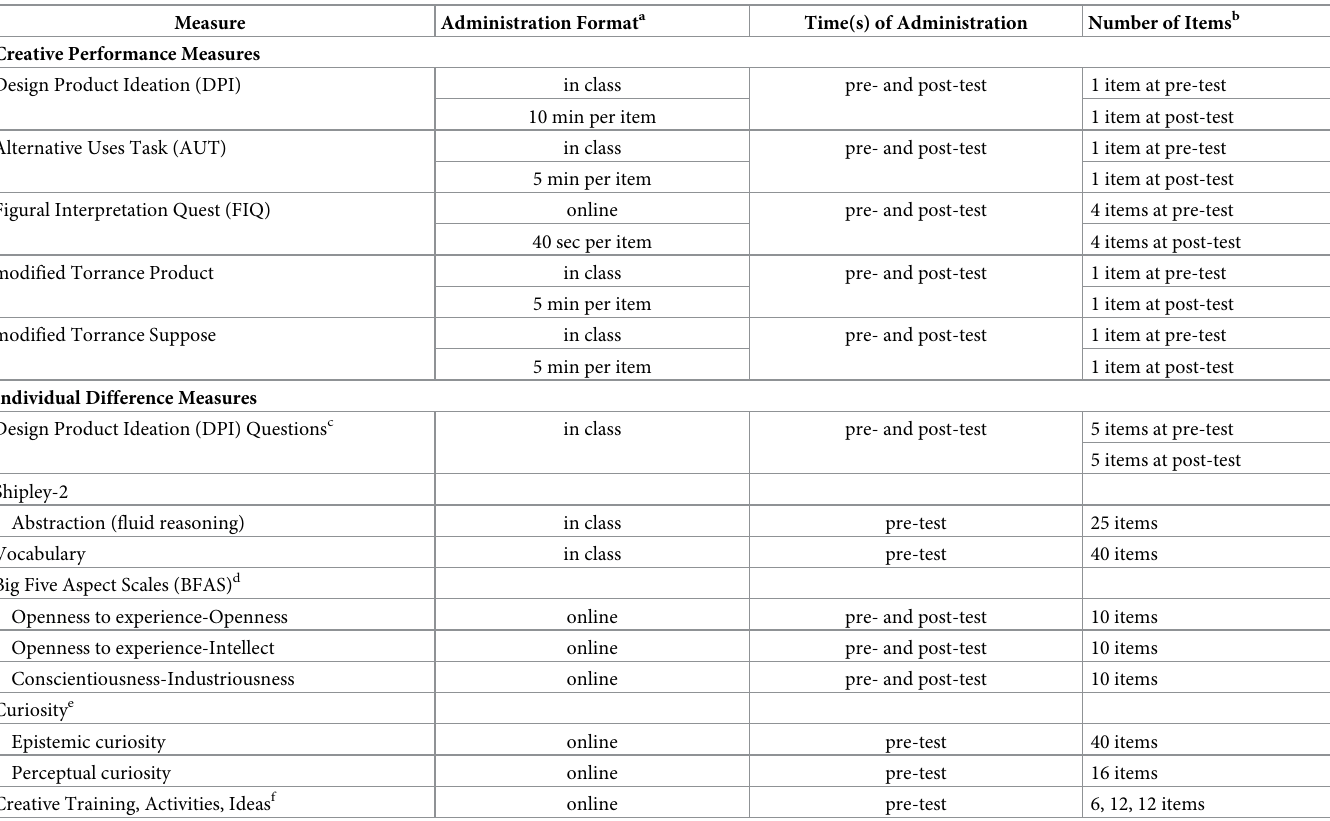
Table 2. Stimulus and task